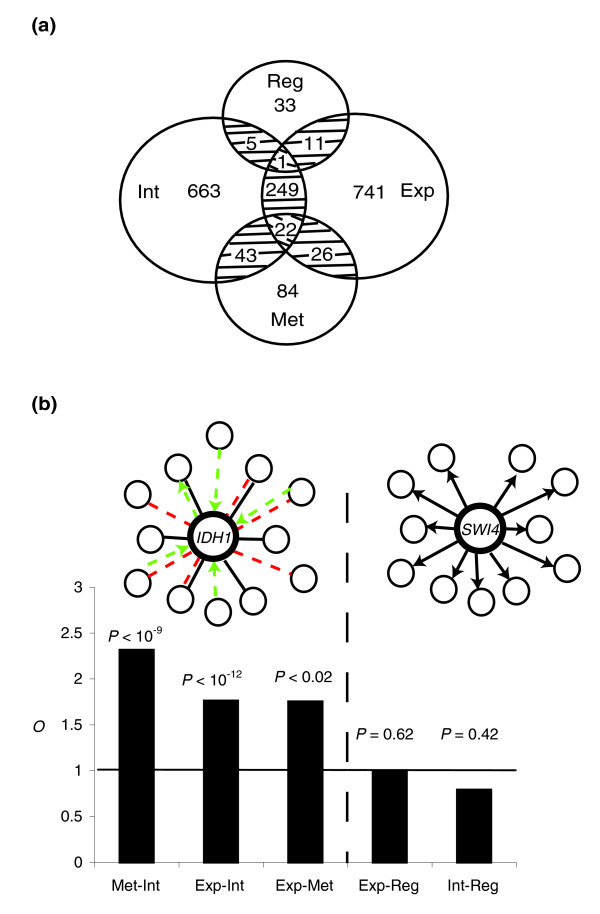
Analysis of hub overlaps. (a) Venn diagram describing hub overlaps between networks. Shaded areas represent composite hubs. (b) Fold enrichments of hub overlaps (O) between two networks relative to random expectation. The bars above the line (where O = 1) show that overlapping hubs between the two networks are more than expected. The schematic above the first three bars shows that action networks tend to share the same hubs. One of the tri-hubs is Idh1p, an isocitrate dehydrogenase involved in the tricarboxylic acid cycle connecting a number of different pathways [7]. It is also involved in a number of complexes, and is thus co-expressed with many other genes [5,6,40,49]. In this schematic, the solid circle represents the composite hub; open circles represent different proteins; black solid lines represent interaction relationships; red dashed lines represent co-expression relationships; green dashed arrows represent metabolic reactions. The schematic above the last two bars shows that the regulatory network uses a distinct set of hubs. For example, Swi4p is a major TF regulating the yeast cell cycle [50]. However, it is not a hub in any of the action networks. In this schematic, the solid circle represents the regulatory hub; open circles represent different proteins; black solid arrows represent regulatory relationships. P values measure the significance of the differences between the observed overlaps and the random expectation. The random expectation was calculated as described in Materials and methods. P values in this figure and all following figures were calculated using the cumulative binomial distribution (Additional data file 1). Met, the metabolic network; Int, the interaction network; Exp, the co-expression network; and Reg, the regulatory network (in Figures 2 and 3, we only consider the regulator population in the regulatory network).